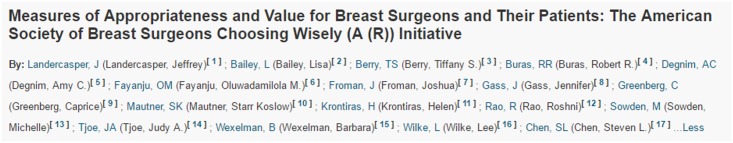
Example of a sequence break due to multiple last names.